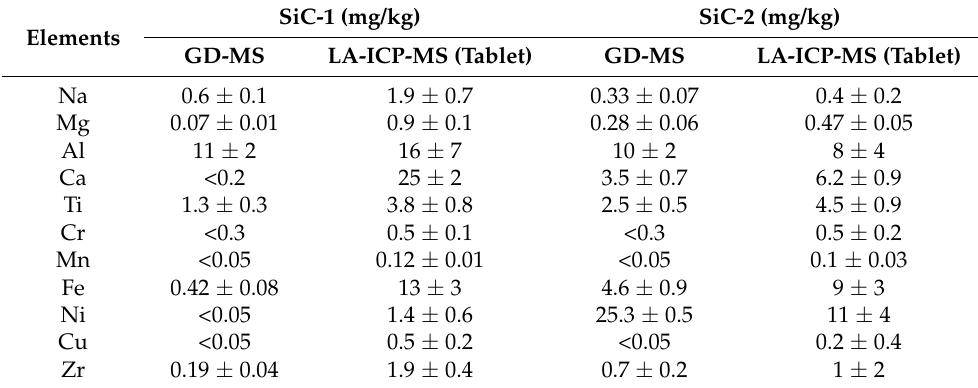
Table 1. Concentrations determined for the 11 selected trace elements in samples SiC-1 and SiC-2 (in tablet form). LA-ICP-MS data were obtained by external calibration (BAM S003a as the single calibrant). Standard deviations of LA-ICP-MS data were calculated by determining the standard deviation of the transient signal. GD-MS data were obtained by using the Relative Sensitivity Factors (RSFs, see details in the experimental section). SiC-1 (mg/kg) SiC-2 Elements